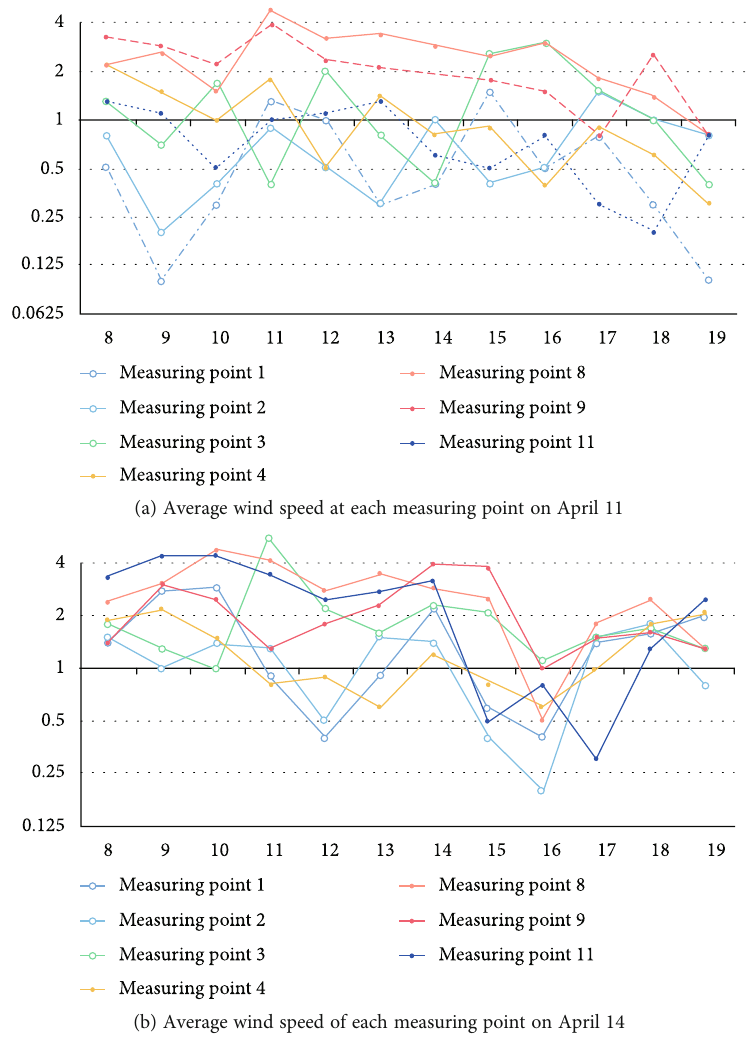
Figure 5: Average air temperature of each measuring point at the test site. Table 2: Meteorological data of Yichun City from 7: 00 to 8 :00 on April 12,